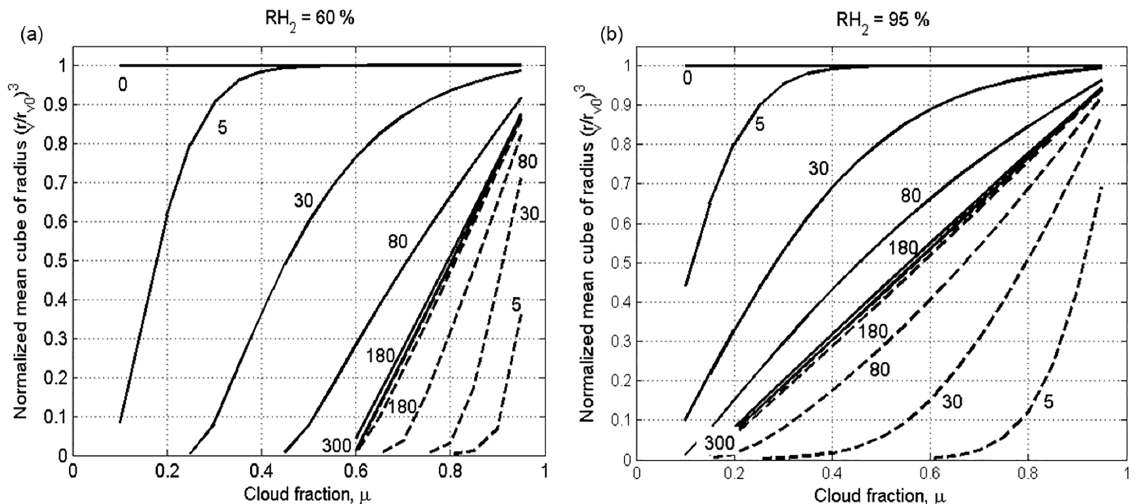
Figure 8. Dependences of the normalized cube of the mean volume radius on the cloud fraction at different time instances for x = 0 (solid lines) corresponding to the initially cloud volume, and x = L (dash line) corresponding to the initially dry volume. The time instances in seconds are marked by numbers. The figure is plotted for the narrow initial DSD for two values of RH 2 : 60% (a) and 95% (b) . Parameters of DSD are given in Table 1. The initial mixing parameters are T = 10 ◦ C, p = 828.8mb and L = 40m. Calculations performed within the range of 0 . 1 < µ < 0 .